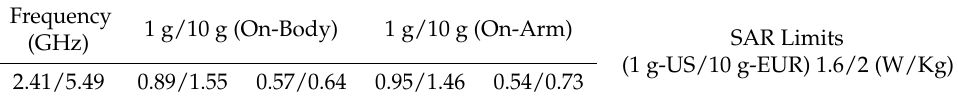
Table 4. Different SAR Values in Bending Positions.